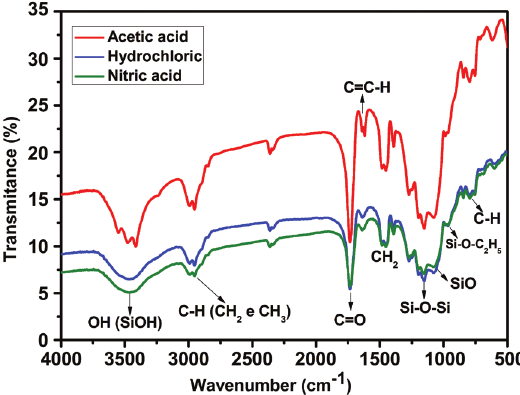
Figure 6. FI-IR spectra of the hybrid films formulated with the three acids studied: acetic, hydrochloric and nitric